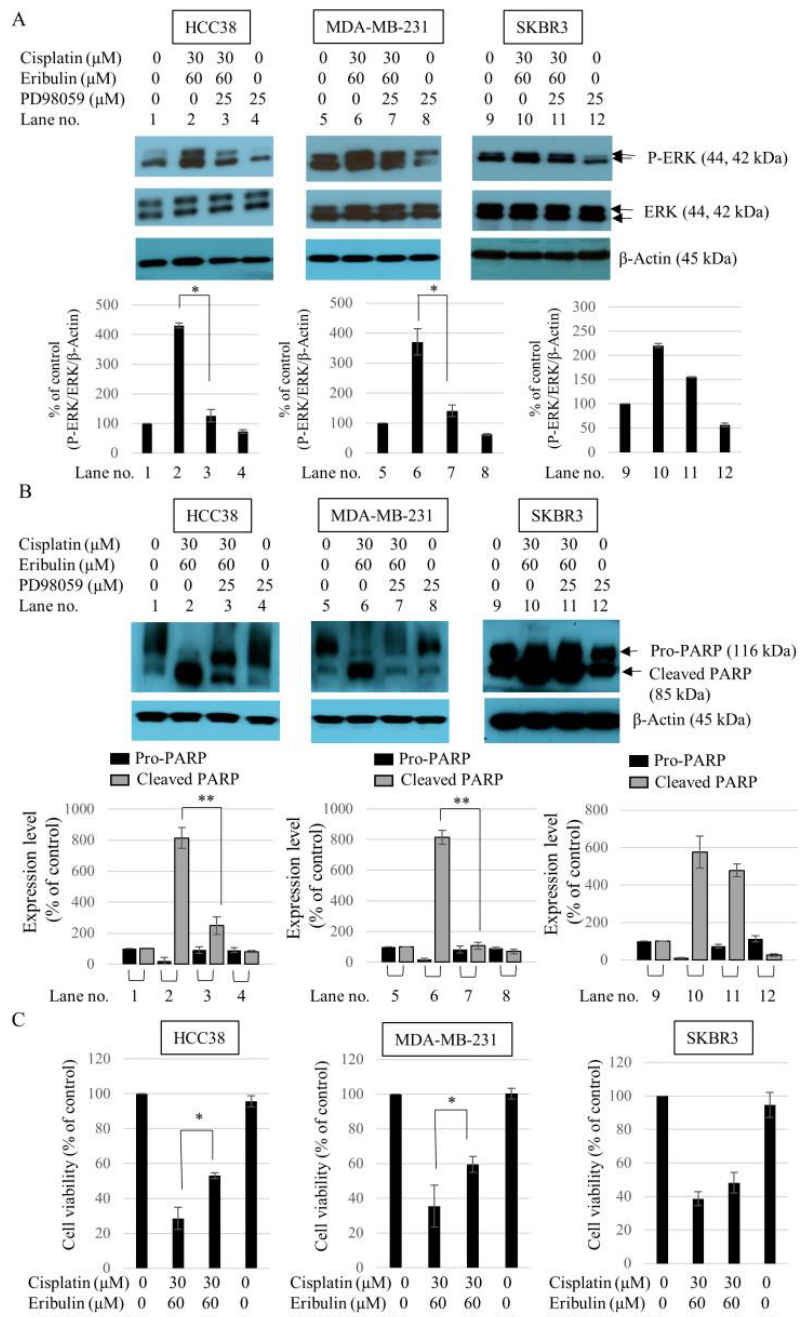
Figure 6. Phosphorylation of ERK1/2 in HCC38, MDA-MB-231, and SKBR3 cells treated with PD98059 and the combination of cisplatin and eribulin. ( A ) Cells were first treated with 25 µM